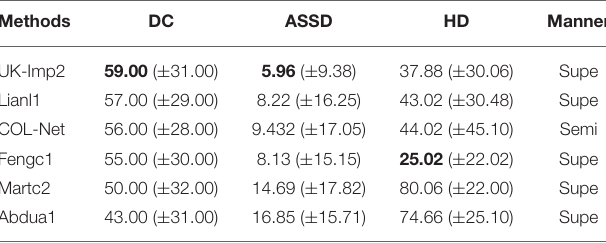
TABLE 5 | The results of the participants of the SISS